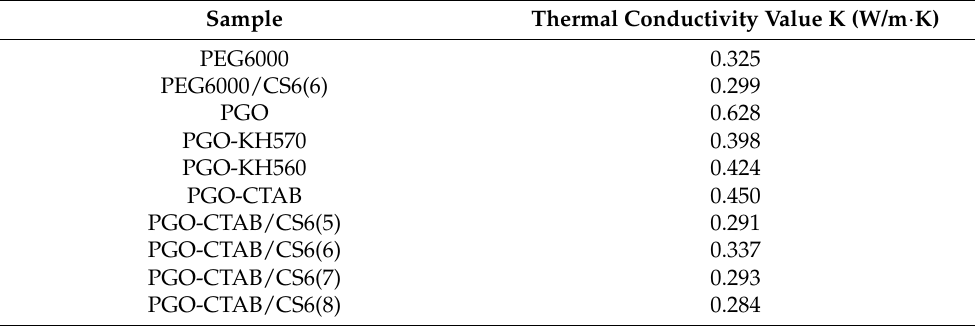
Figure 10. ( a , b ) Thermal conductivity at 25 ◦ C and ( c ) photo-thermal conversion curves of various PCMs. ( d ) Thermal cycle stability of PGO-CTAB/CS6(6) phase change composites. Table 6. Thermal conductivity of pure PEG6000 and various composite